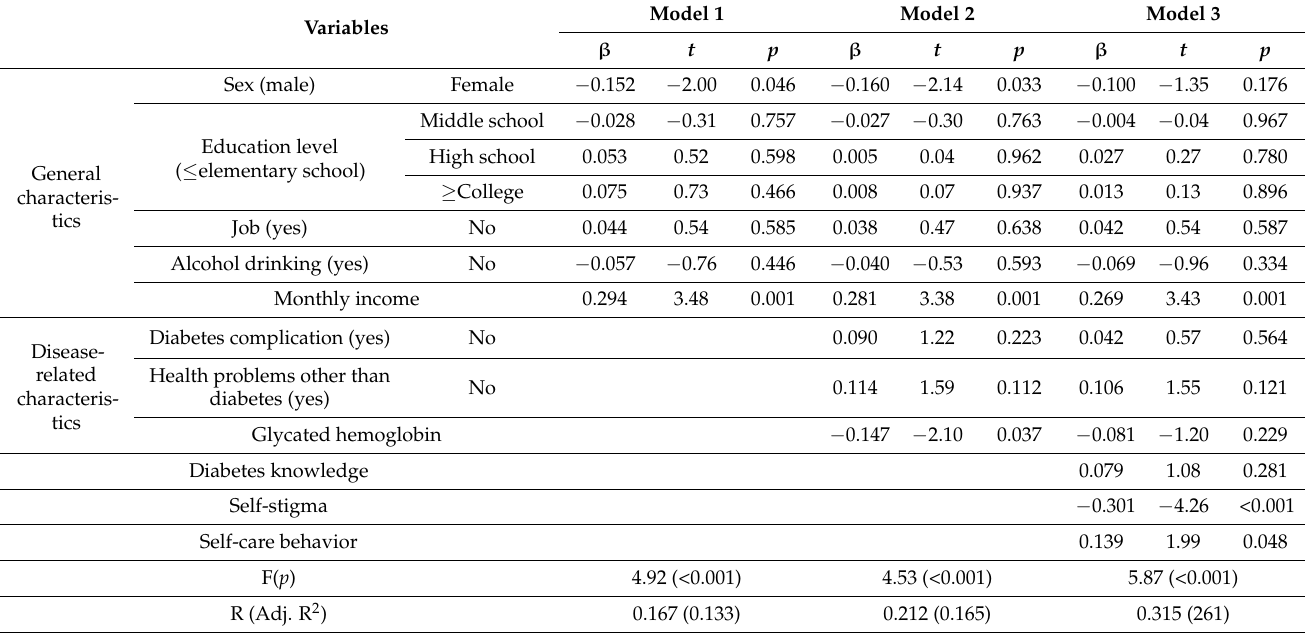
Table 4. Hierarchical multiple linear regression analysis for quality of life (N =